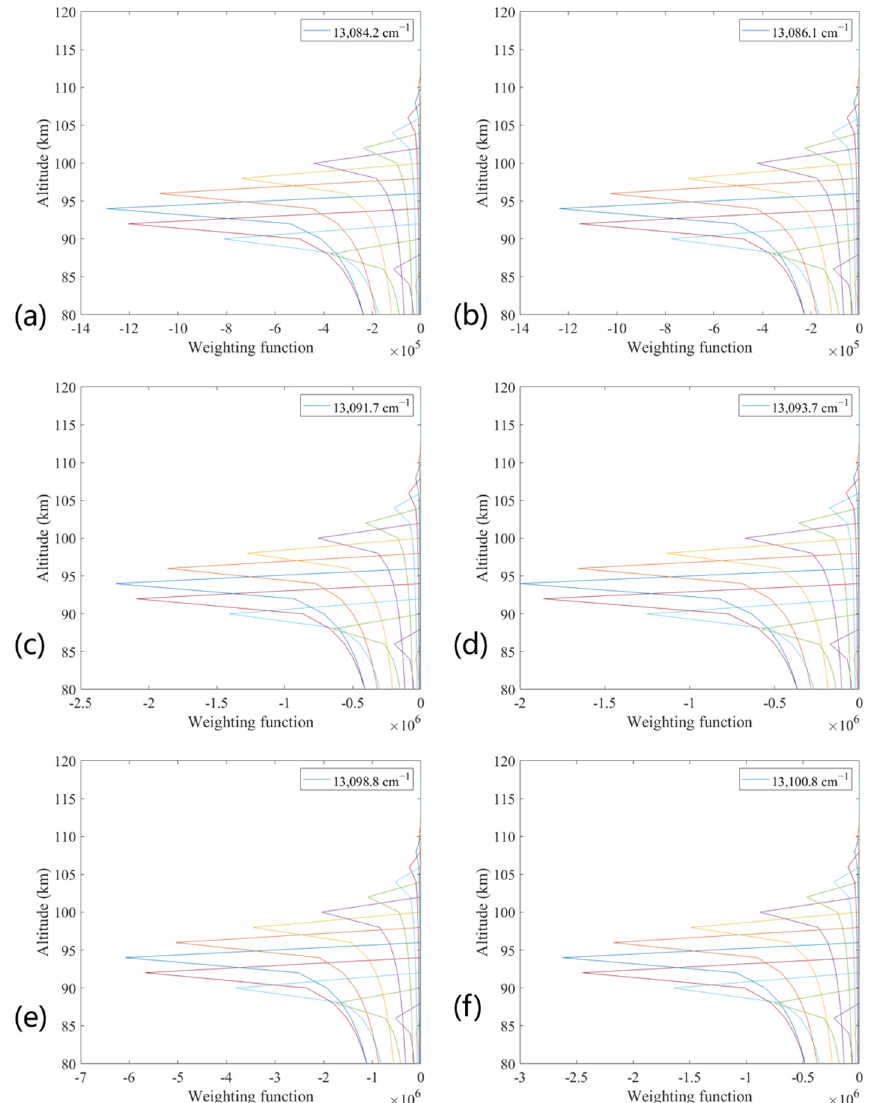
Figure 9. Weighting function matrix of target emission line with respect to temperature. Subgraph ( a – f ) correspond to the weighting function of the six emission lines in figures, respectively. Different colors represent rows of K, where the weighting function for a specific tangent height is the row that peaks at that altitude.